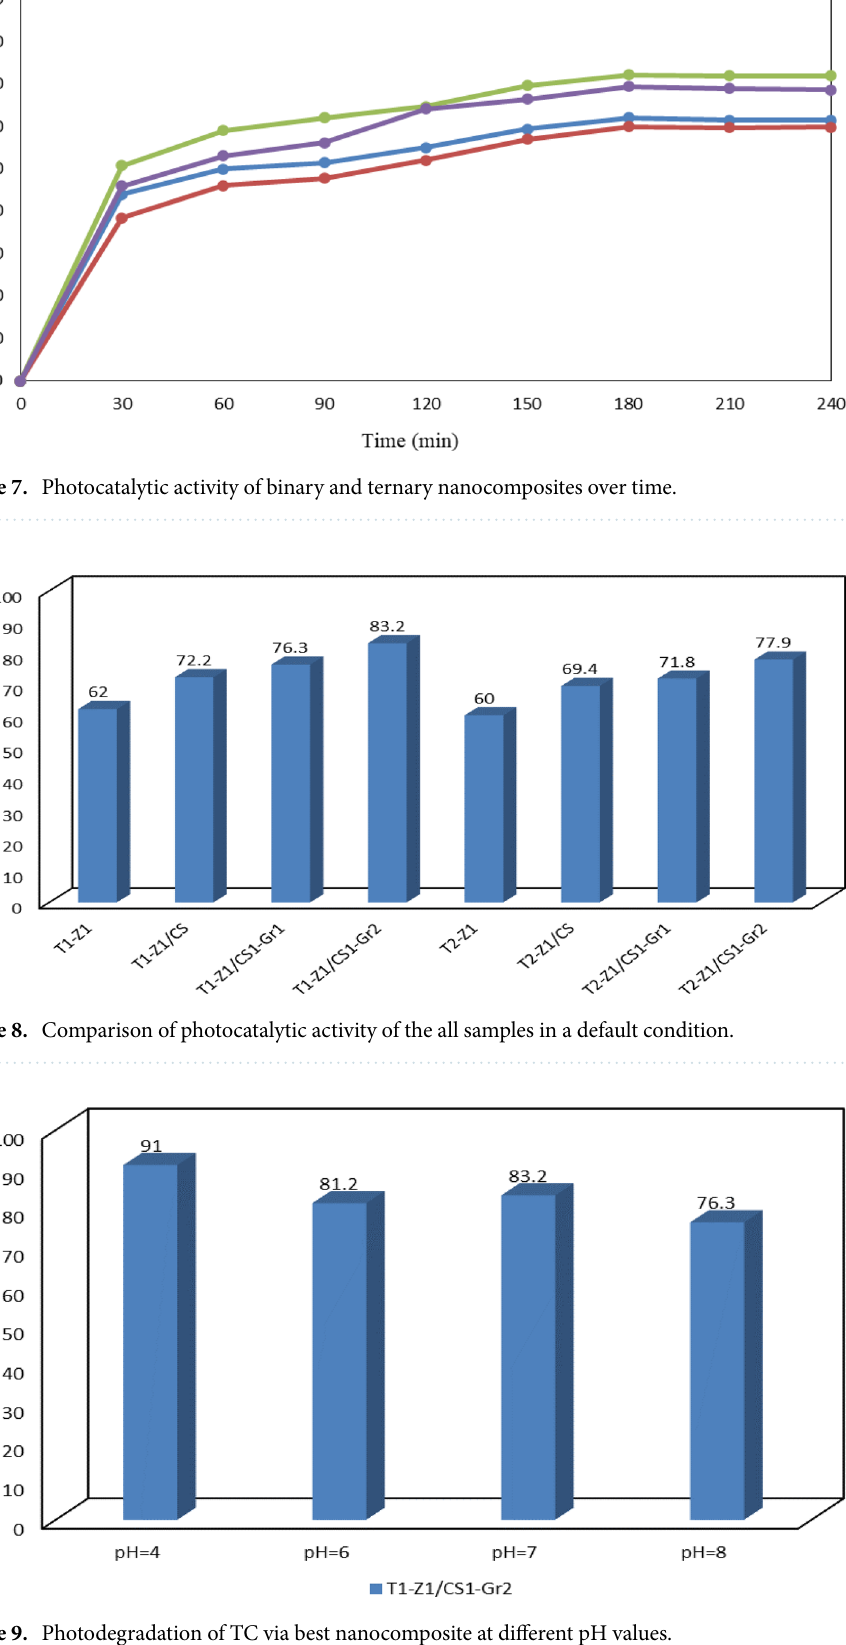
Figure 9. Photodegradation of TC via best nanocomposite at different pH